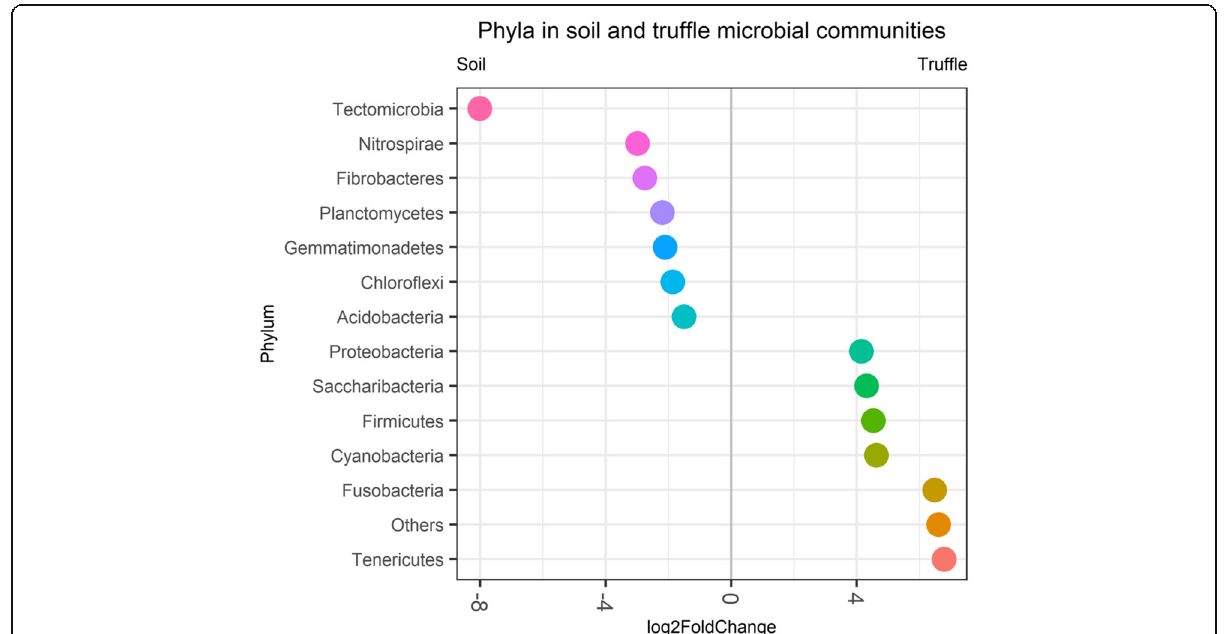
Fig. 3 Differentially abundant phyla in soil (on the left) and truffle (on the right) microbial